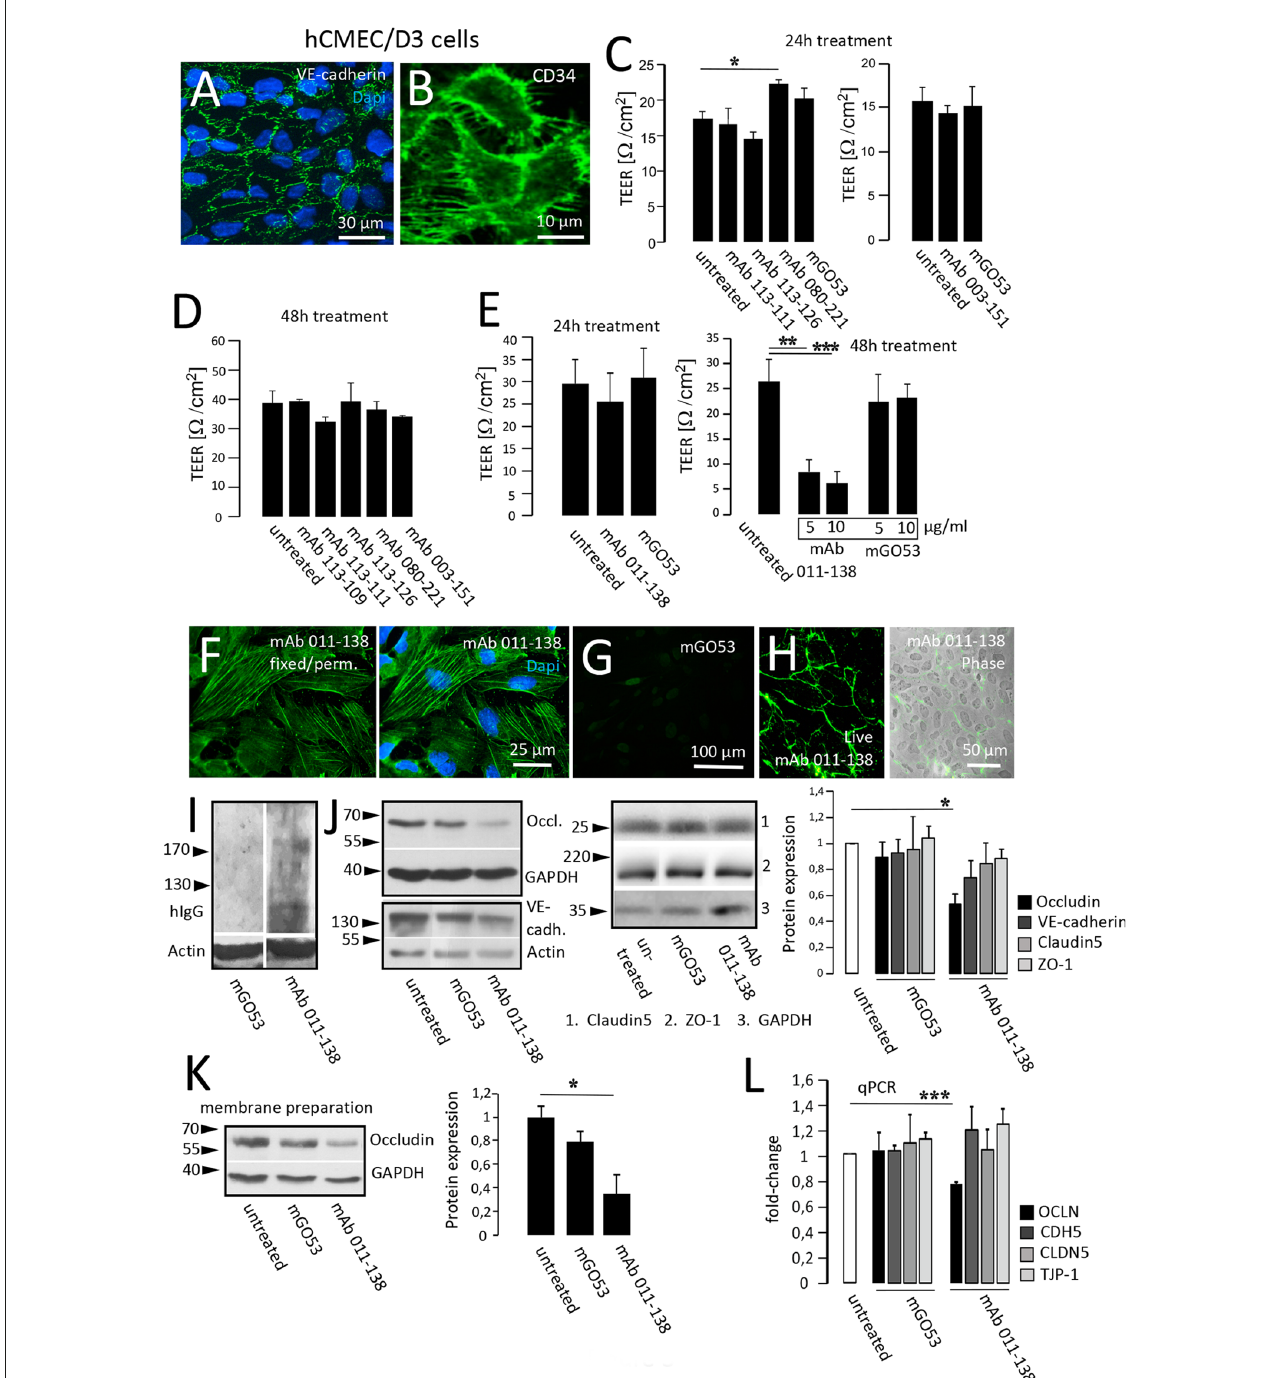
FIGURE3 Antibody 011-138 decreases transendothelial electrical resistance and downregulates tight junctional Occludin. (A,B) Human cerebral microvascular endothelial cells (hCMEC/D3) were used as an in vitro blood-brain barrier model. Tight junction protein VE-cadherin and the endothelial cell marker CD34 were clearly expressed and depicted adjacent cell boundaries. The following functional experiments were carried out on live cells grown to confluence. (C) After 24 h of antibody treatment at 5 µ g/ml, none of the human monoclonal antibodies (mAb) decreased TEER, only mAb 080- 221 increased TEER. (D) No effects on TEER were observed after incubation for 48 h with 5 µ g/ml with the respective antibodies. (E) Incubation with 5 µ g/ml mAb 011-138 for 24 h had no significant effects on TEER. Conversely, incubation for 48 h resulted in a highly significant reduction of electrical resistance by mAb 011-138, but not mGO53, used as control Ab. Values analyzed in triplicates are expressed as means ± SEM from a representative experiment that was at least repeated once per condition (C–D) or from three independent experiments (E) . (F–H) Immunofluorescence detection of mAb 011-138 binding (5 µ g/ml) to either live or fixed and permeabilized hCMEC/D3 cells. Fixed cells revealed a filamentous signal of mAb 011-138, and live cells showed a rather surface localized signal. Incubation with mGO53 resulted in no signal under either condition ( G , shown for fixed cells). (I) Western blotting of hCMEC/D3 cell homogenates with either mAb 011-138 or control mGo53. Bound monoclonal 011-138 expressed higher molecular weight bands with a prominent signal at or above 200 kDa, mGO53 revealed no immune signal. (J) Confluent hCMEC/D3 cells were incubated for 48